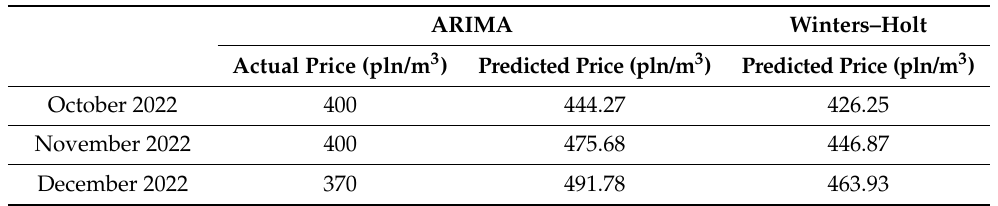
Table 4. Paper chip price prediction for October–December 2022.